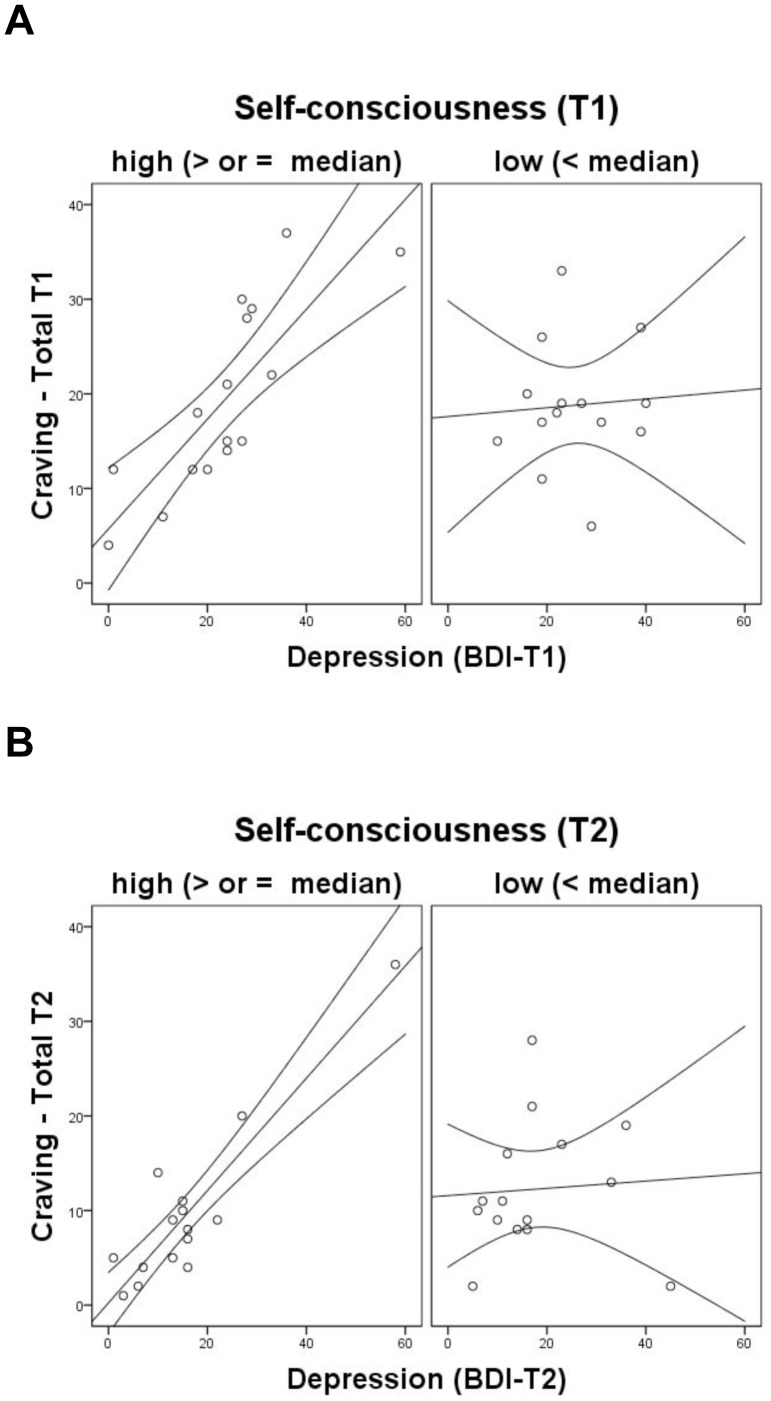
Relation between craving and depression scores as a function of self-consciousness.The relations were depicted for T1 (panel A) and T2 (panel B). In the four graphs, the curves around the regression line delineate a 95% confidence relation between craving and depression scores.